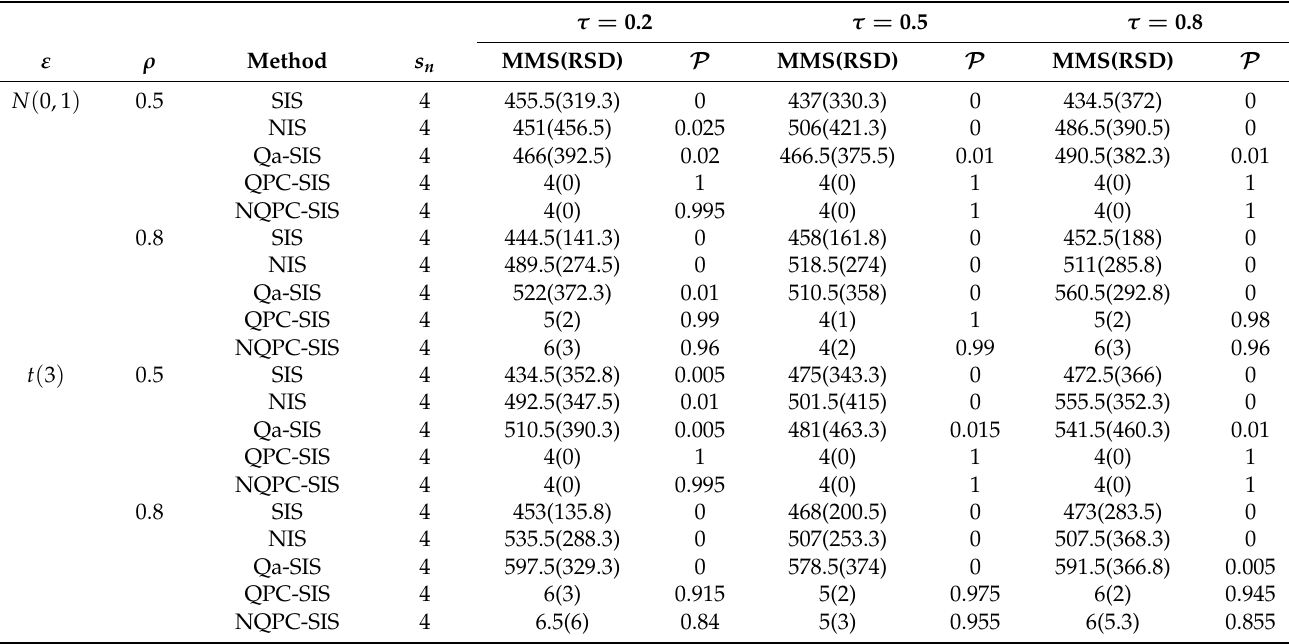
Table 1. Simulation results for Example 1 when n = 200.